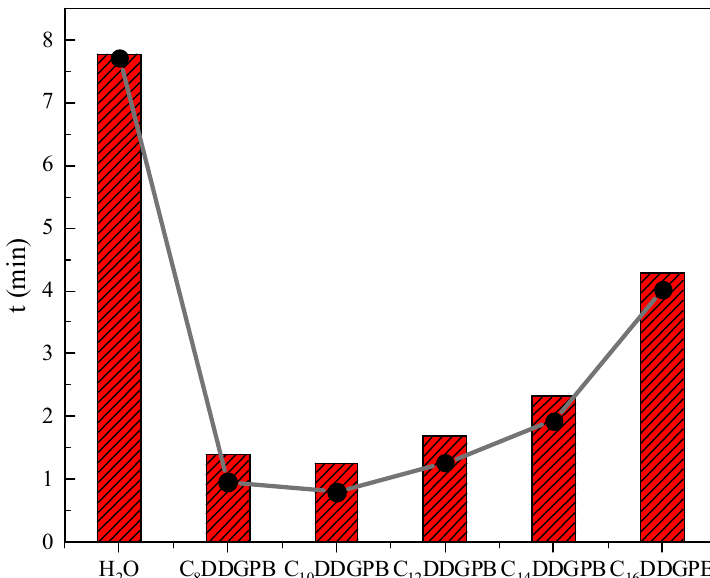
Figure 7. Solution wetting performance diagram for C n DDGPB.